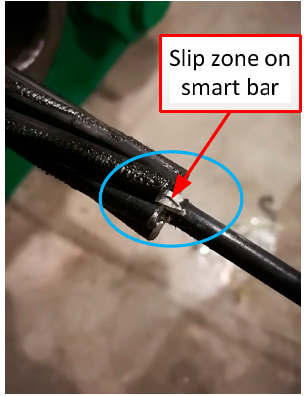
Figure 7. Photographs of the cable end after tensioning.